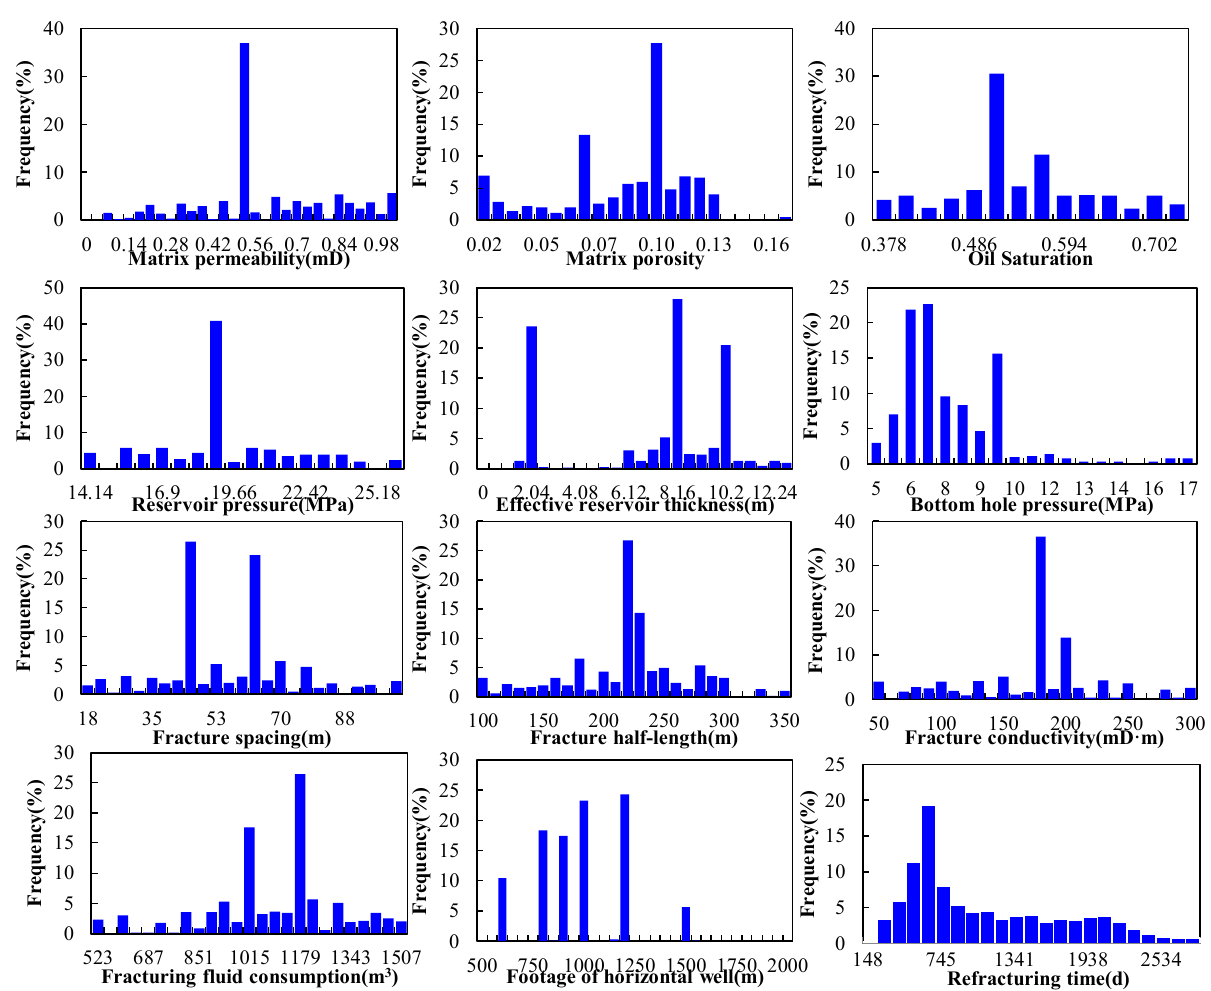
Figure 4. Distribution of input and output variables.